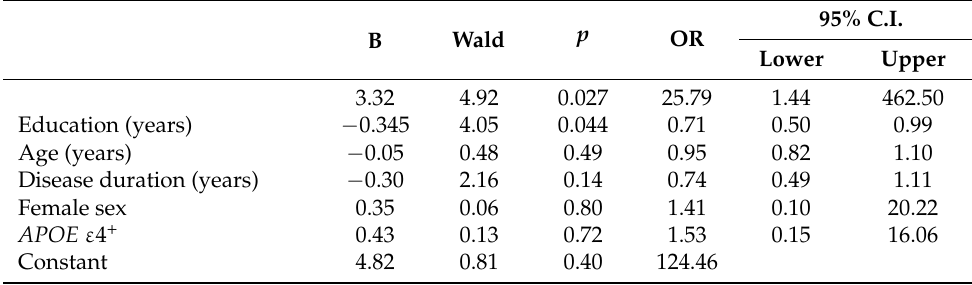
Table 2. Logistic regression model for multivariate analysis.